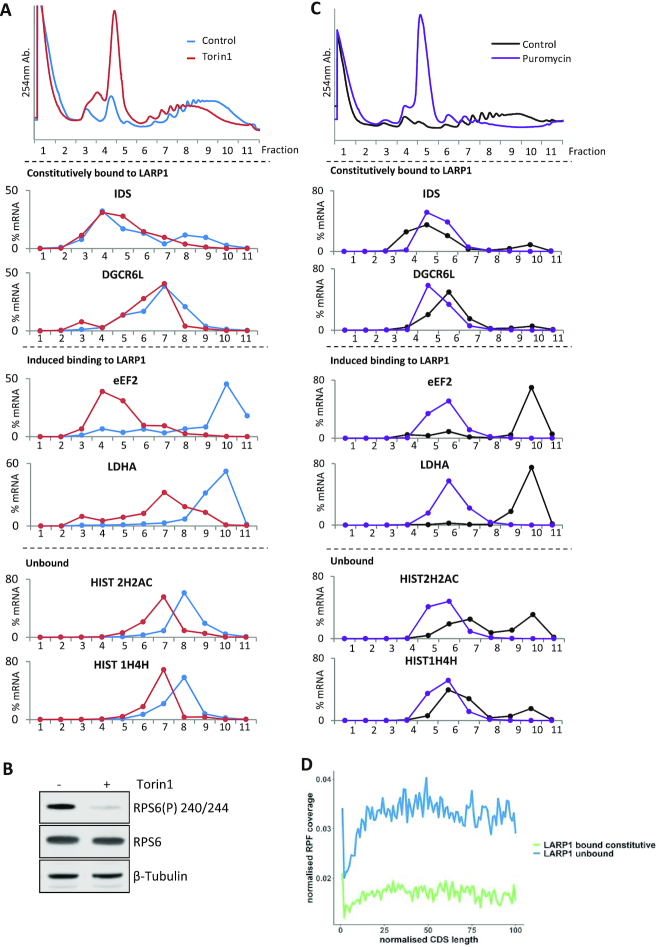
Polysome distribution of LARP1 bound mRNAs. HeLa cells supplemented with serum and then 200 nM Torin1 or DMSO vehicle control. (A-C) Sucrose density gradients were run and RNAs extracted from individual fractions. (A) Top panel: UV 254 traces of polysome gradients from control and Torin1 treated HeLa cell extracts. Lower panels: Percentage mRNA distribution across polysome gradients calculated from RT-qPCR. Data presented from one experiment representative of three independent experiments. (B) Western blots of input samples from A, for one of three independent experiments using indicated antibodies. (C) HeLa cells were treated with 200 μg/ml Puromycin for 1 h or 100 μg/ml cycloheximide for 3 min (Control). Sucrose gradients as in A. RNA was extracted from individual fractions and qPCR performed. Top panel: UV 254 traces of polysome gradients from control and puromycin treated HeLa cell extracts. Lower panels: Representative percentage mRNA distribution across polysome gradients calculated from RT-qPCR. (D) LARP1 constitutively bound mRNAs show reduced ribosome occupancy across the CDS. Graph shows RPF coverage normalized for mRNA abundance against normalized CDS length.